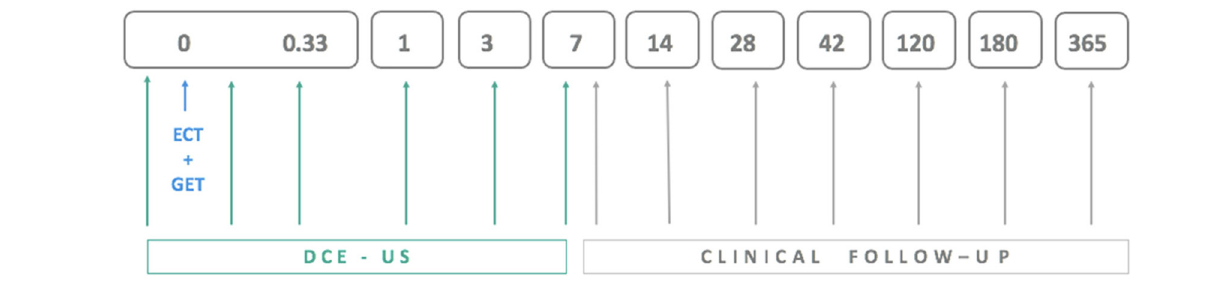
(Bracco, Milan, Italy) was administered into the cephalic vein at dose 0.5–1.5 mL per dog, depending on the weight of the animal ( < 10 kg: 0.06 mL/kg, 10–20 kg: 0.05 mL/kg, 20–30 kg: 0.04 mL/kg, and > 30 kg: 0.03